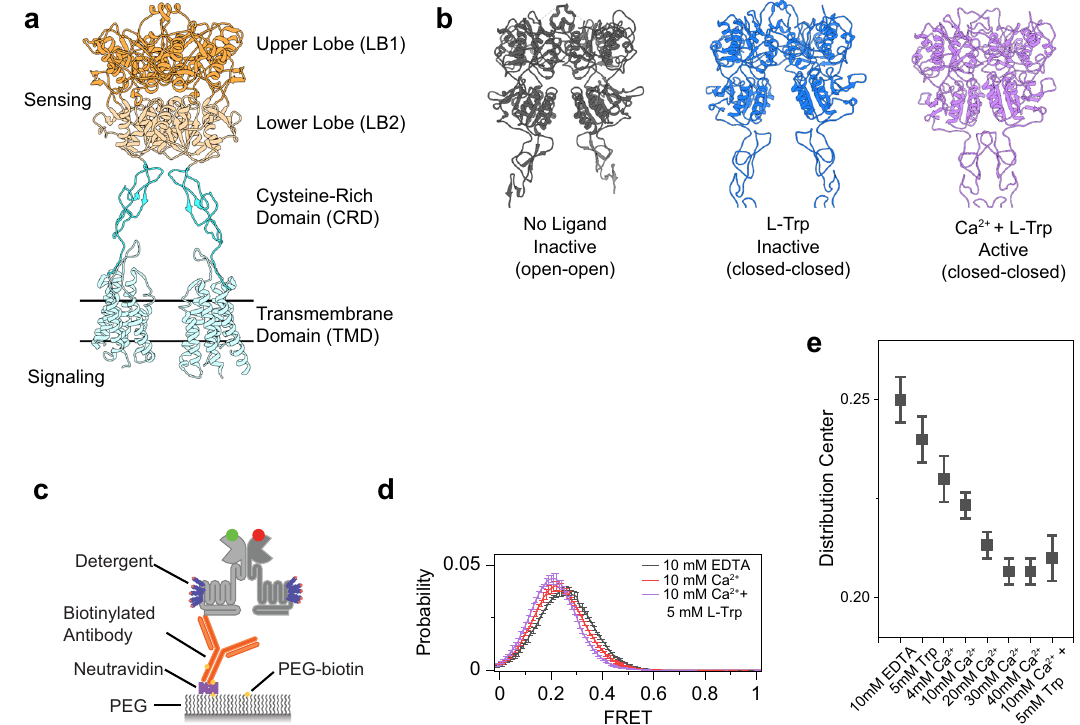
Fig. 1 CaSR is an intrinsically dynamic receptor, and ligands stabilize the active conformation. a Ribbon representation the CaSR structure (PDB ID: 7DTW) colored to highlight the upper lobe (orange), lower lobe (pale orange), cysteine-rich domain (cyan), and the transmembrane domain (pale cyan). b Ribbon representation of the CaSR ectodomain in the Ioo, Icc, and Acc conformations (PDB IDs: 5K5T, 7DTU, and 7DTV respectively). c Schematic of single-molecule FRET experiments. d smFRET population histograms in the presence of 10 mM EDTA, 10 mM Ca 2 + , or 10 mM Ca 2 + and 5 mM L -Trp. Data represent mean ± s.e.m. of n = 3 independent biological replicates. e Center of a single gaussian distribution fi t to FRET histograms. Data represents the mean ± s.e.m. of n = 3 fi ts to independent biological